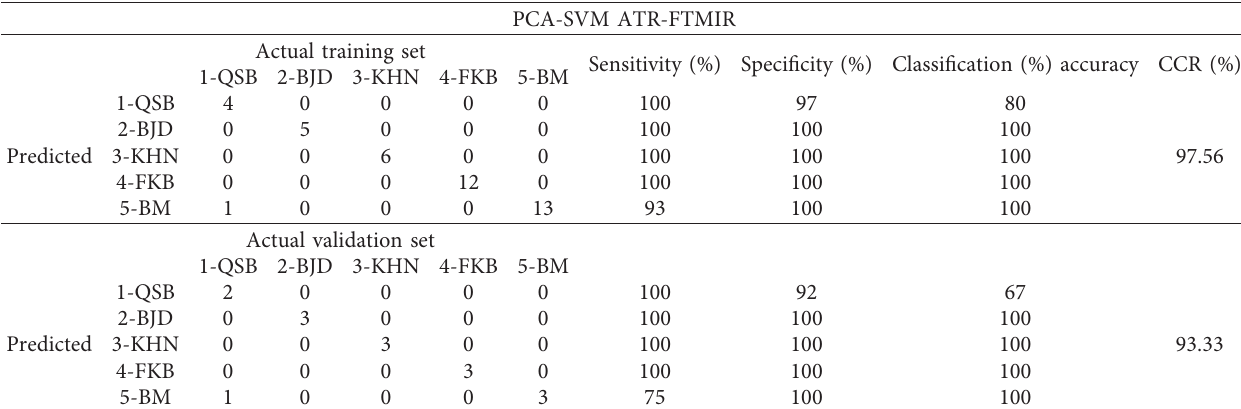
Table 5: Confusion matrix of PCA-SVM results on the first four principal components of ATR-FTMIR spectral